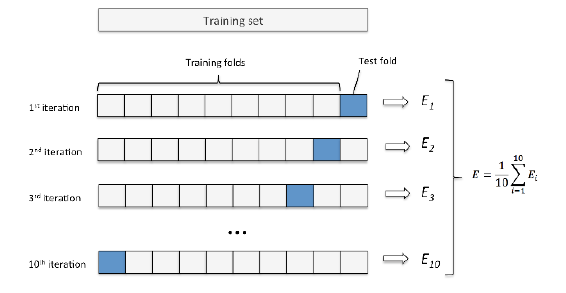
Figure 3. K -fold cross-validation (10-fold cross-